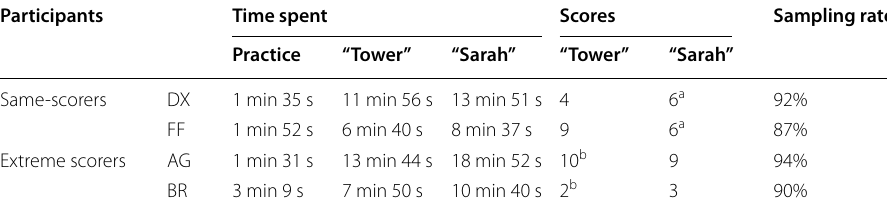
Note . AG took “Sarah” as the 1st task. a or b indicates pair comparison